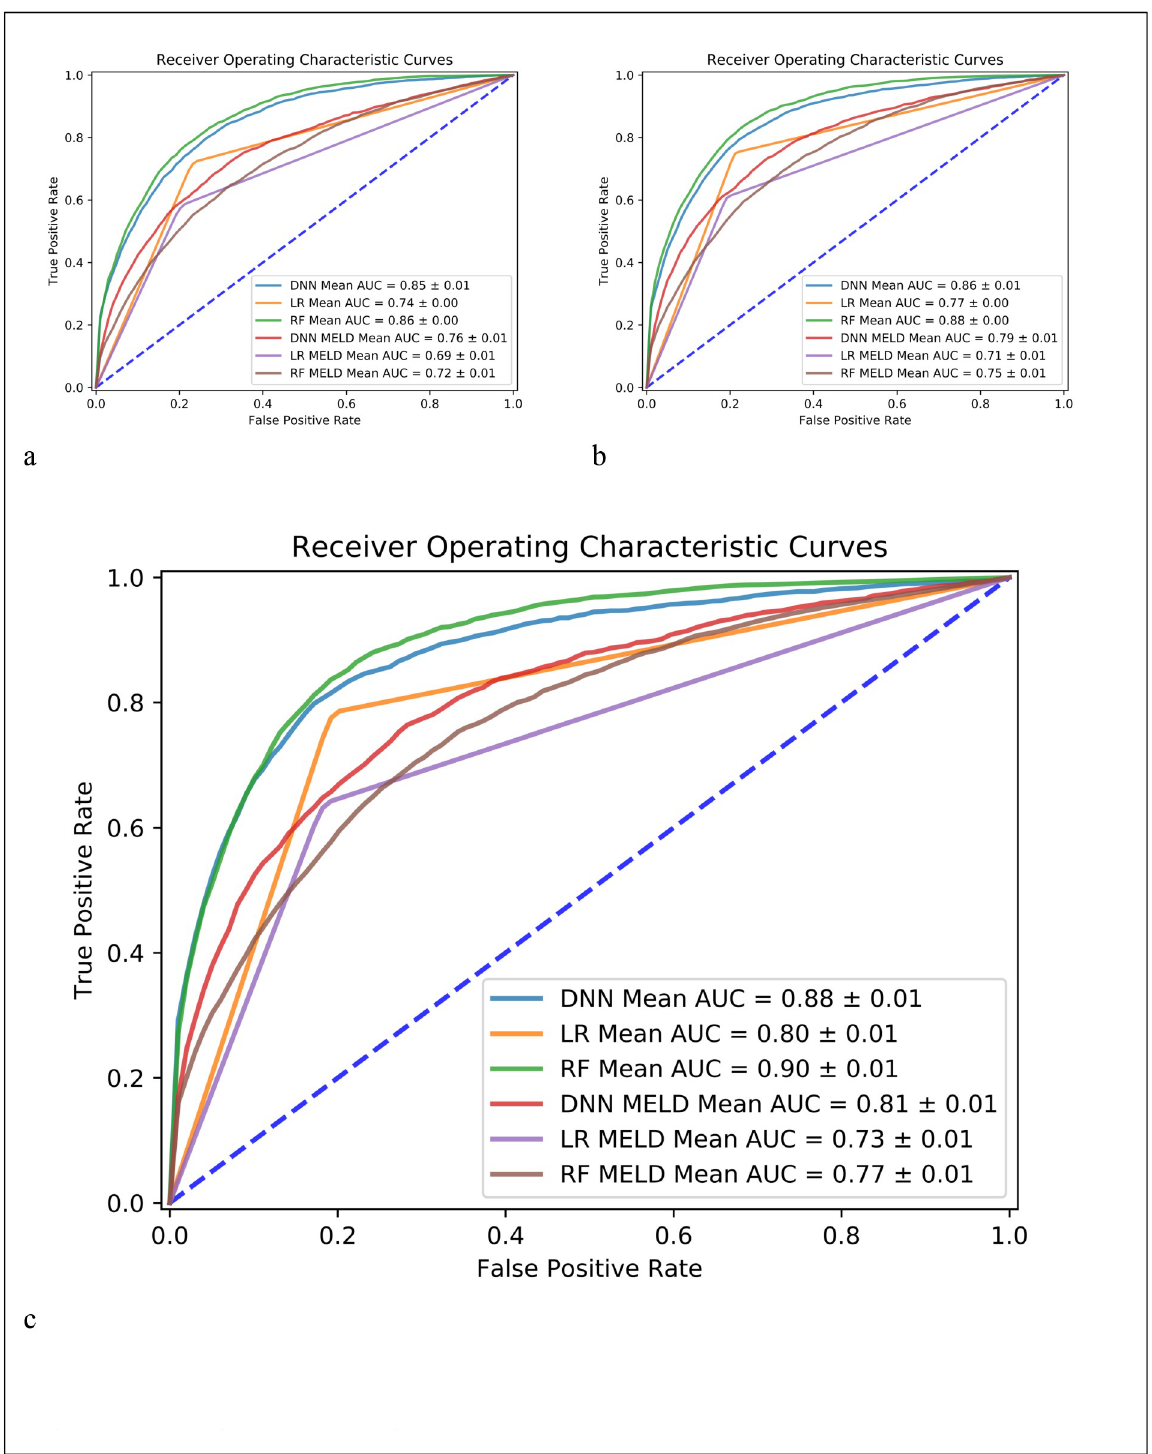
Fig 2. Prediction performance by deep neural network (DNN), random forest (RF) and logistic regression (LR). Figure a, b, c is for the case of mortality within 365 days, 180 days, and 90 days, respectively.